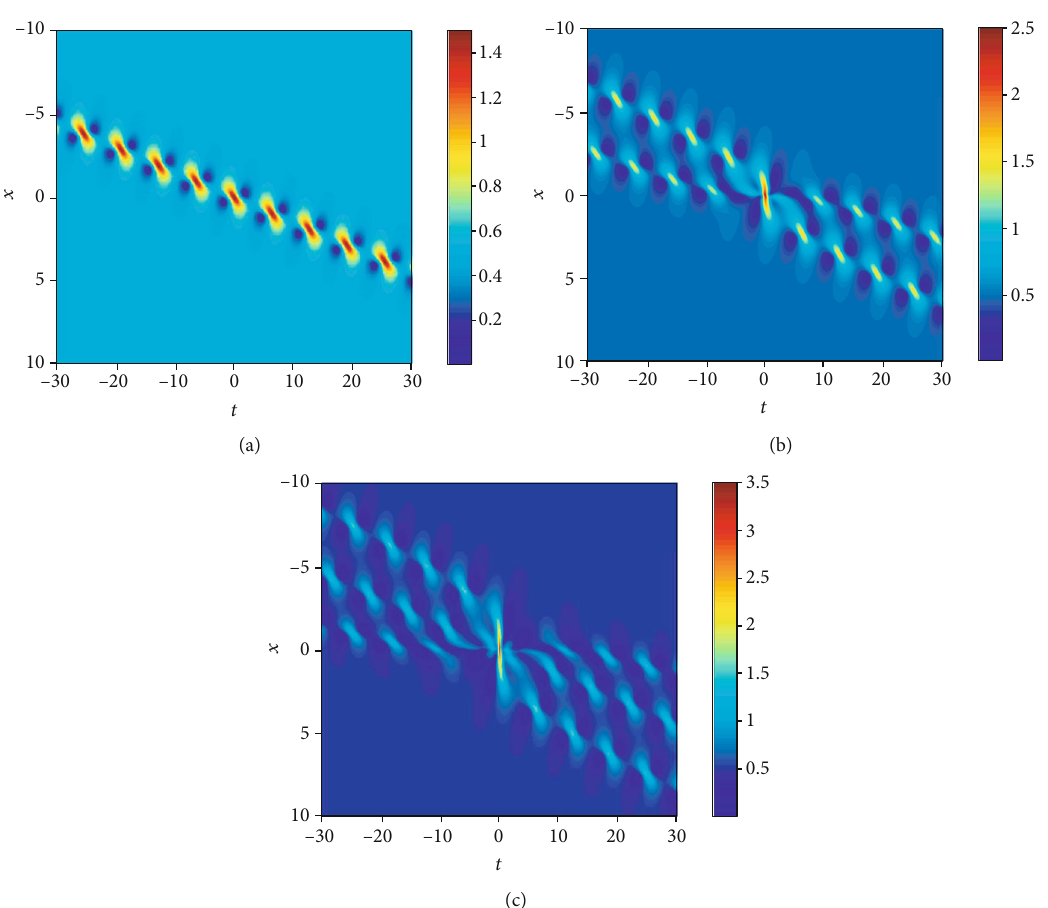
= 1 + i (color online). (a) A fi rst-order 1